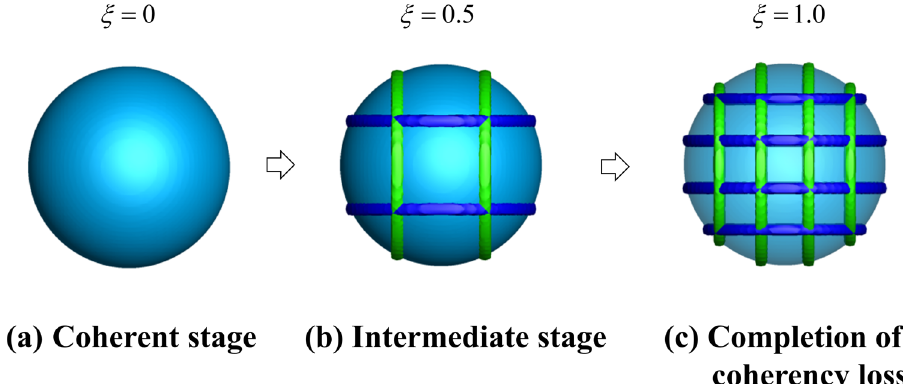
Fig. 1 Schematic of the transition of a precipitate from coherent to semi-coherent state. The blue and green bands represent interfacial dislocation loops with different Burgers vectors. Note that the two sets of dislocations may appear in sequence according to Weatherly and Nicholson 11 , not necessarily the same as what is shown in this